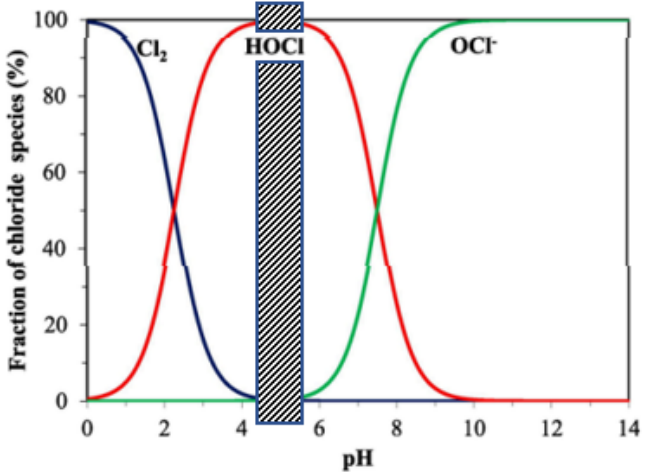
Figure 3. Fraction of aqueous active chlorine species as function of pH, calculated using a composition of 0.05 mol · L − 1 NaCl at standard temperature and pressure (Adapted from [27]).